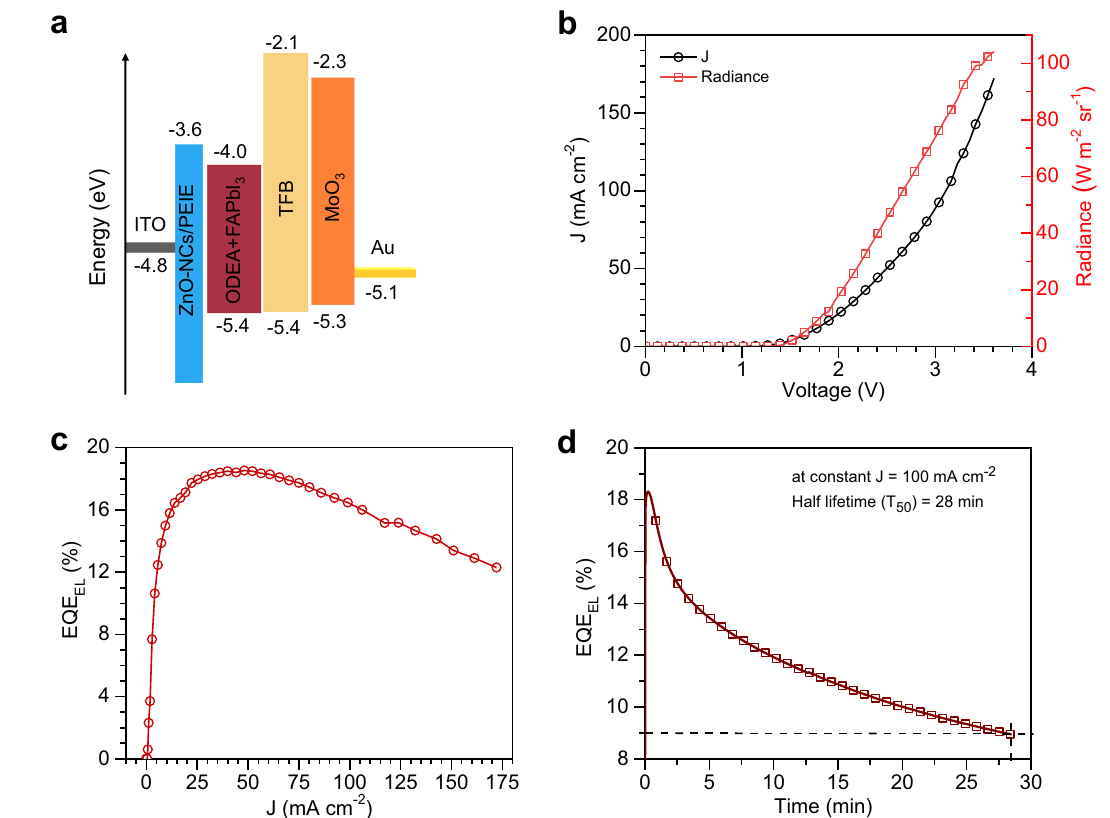
Fig. 1 Device performance and stability characterisations of the near-infrared (NIR) perovskite light-emitting diodes (PeLED). a Energy levels of the materials used in the NIR PeLED. b Current density-voltage-radiance (J – V – R) characterisation of the champion device, maximum radiance of 104 W m − 2 sr − 1 at 3.6 V. c Electroluminescence external quantum ef fi ciency (EQE − 2 . d Device EL ) versus current density curve, peak EQE EL of 18.5% at 50 mA cm stability curve at a constant current density of 100 mA cm − 2 to obtain half lifetime ( T 50 = 28 min) of the